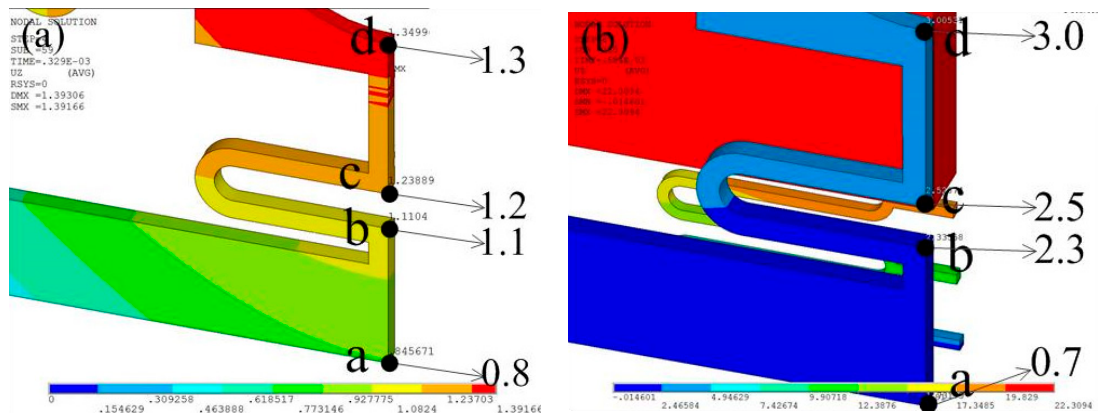
Figure 8. The maximum displacement of the stationary electrode when an overload acceleration of 800 g was applied. ( a ) The maximum displacement of the stationary electrode without contact. ( b ) The maximum displacement of the stationary electrode contacted by the proof mass.